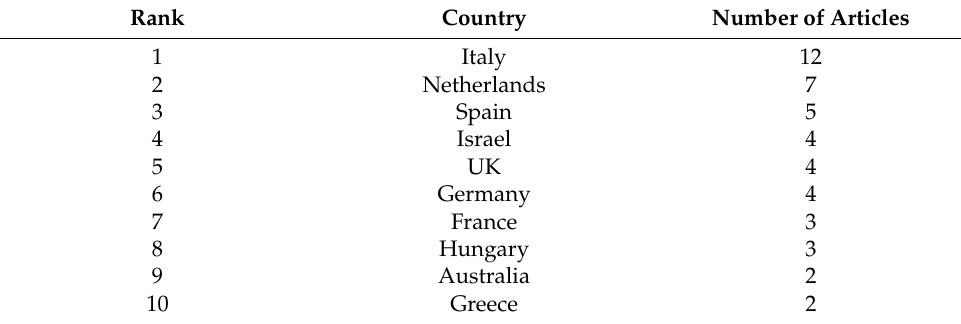
Figure 2. Dynamics of yearly publications. Table 2. Top 10 countries with the highest number of publications.